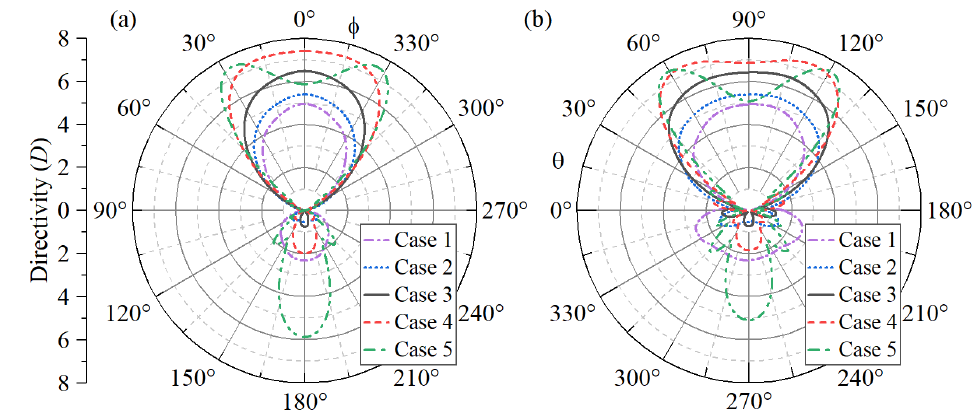
Figure 4. Far-field radiation patterns for the five scenarios in ( a ) azimuth and ( b )